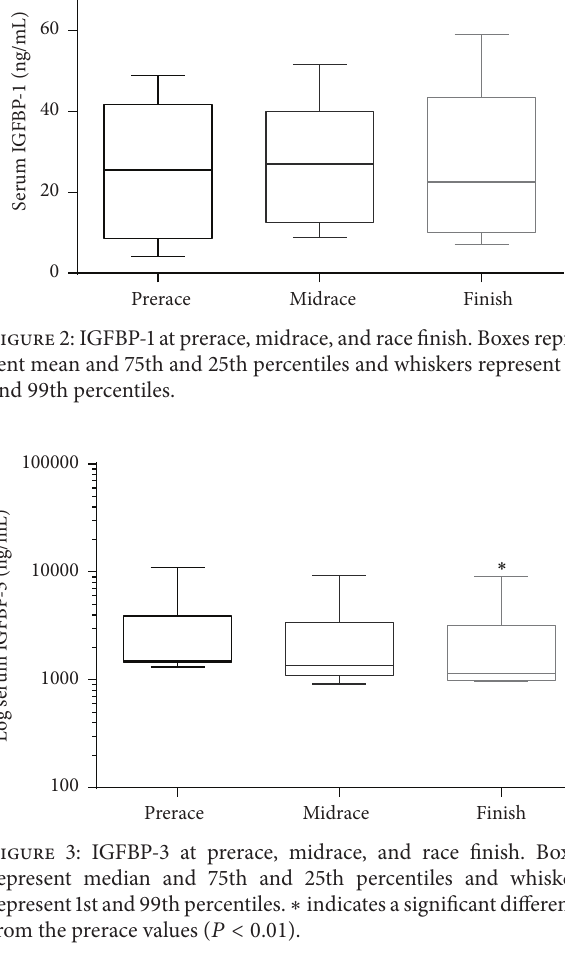
Table 1: Dog identification, age, gender, and starting and ending body conditions for all dogs examined ( 𝑛 -12).